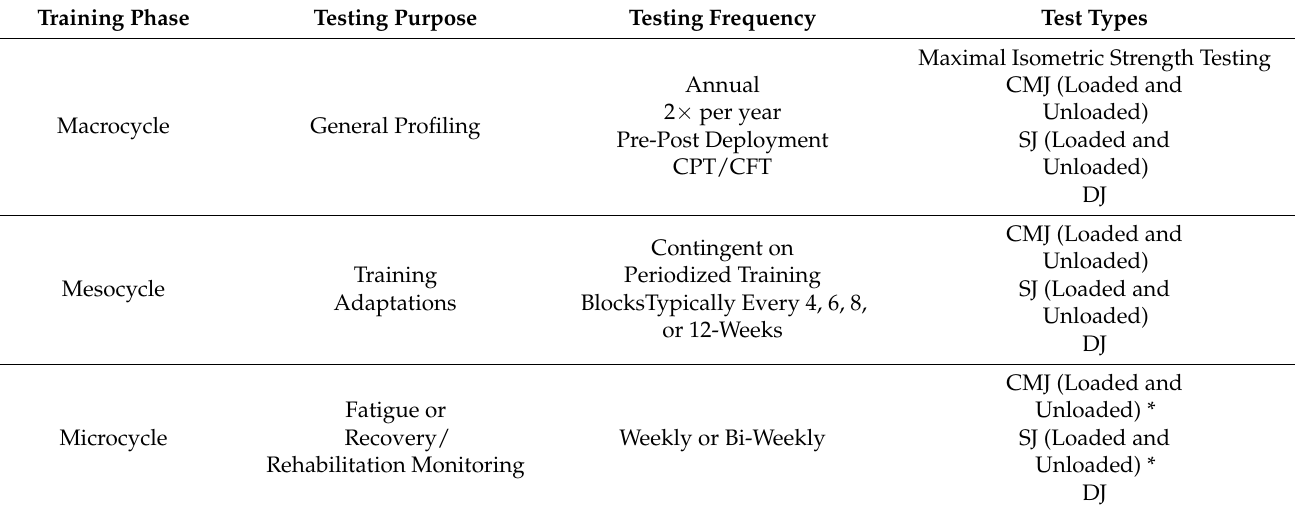
Table 3. Scenarios for monitoring training adaptations and relevant variables to